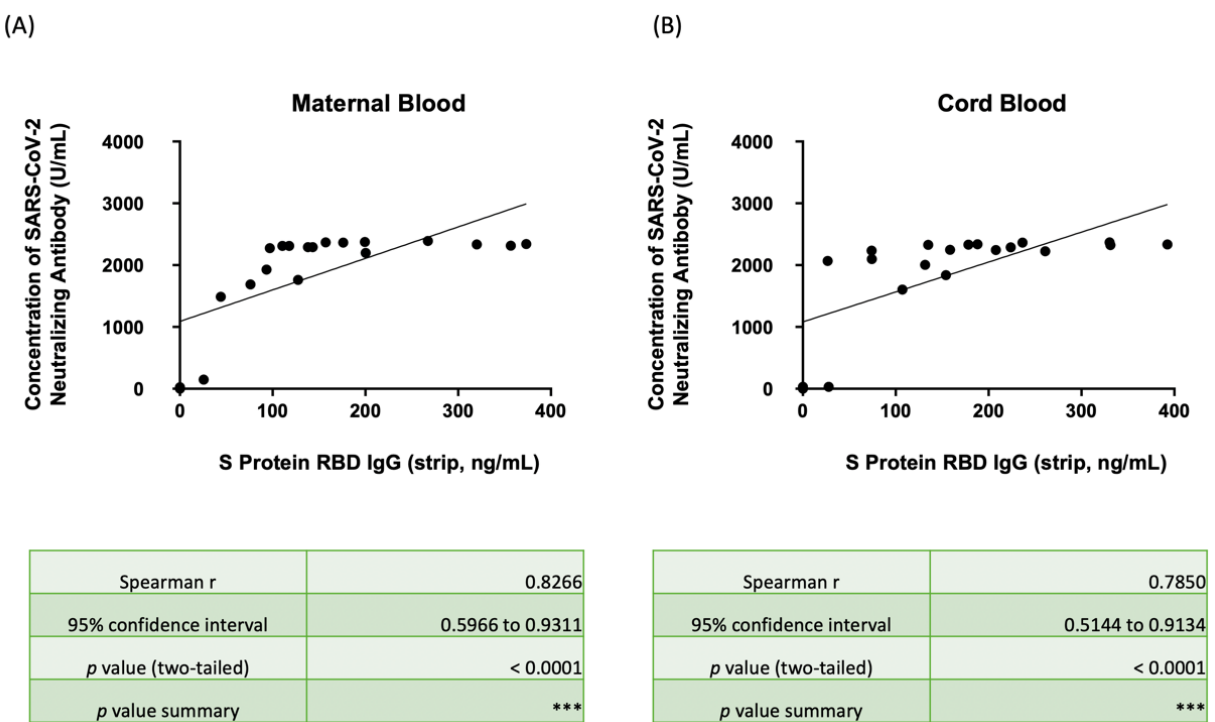
Figure 5. ( A ) Scatter plot showing the correlation between SRBD IgG by the lateral flow immunoas- say/spectrum analyzer and the neutralizing antibody concentration against wild-type SARS-CoV-2 by ELISA in maternal serum. ( B ) Scatter plot showing the correlation between SRBD IgG by the lateral flow immunoassay/spectrum analyzer and the neutralizing antibody concentration against wild-type SARS-CoV-2 by ELISA in neonatal cord blood. SRBD, spike protein receptor binding domain; ELISA, enzyme-linked immunosorbent assay. *** p < 0.001.